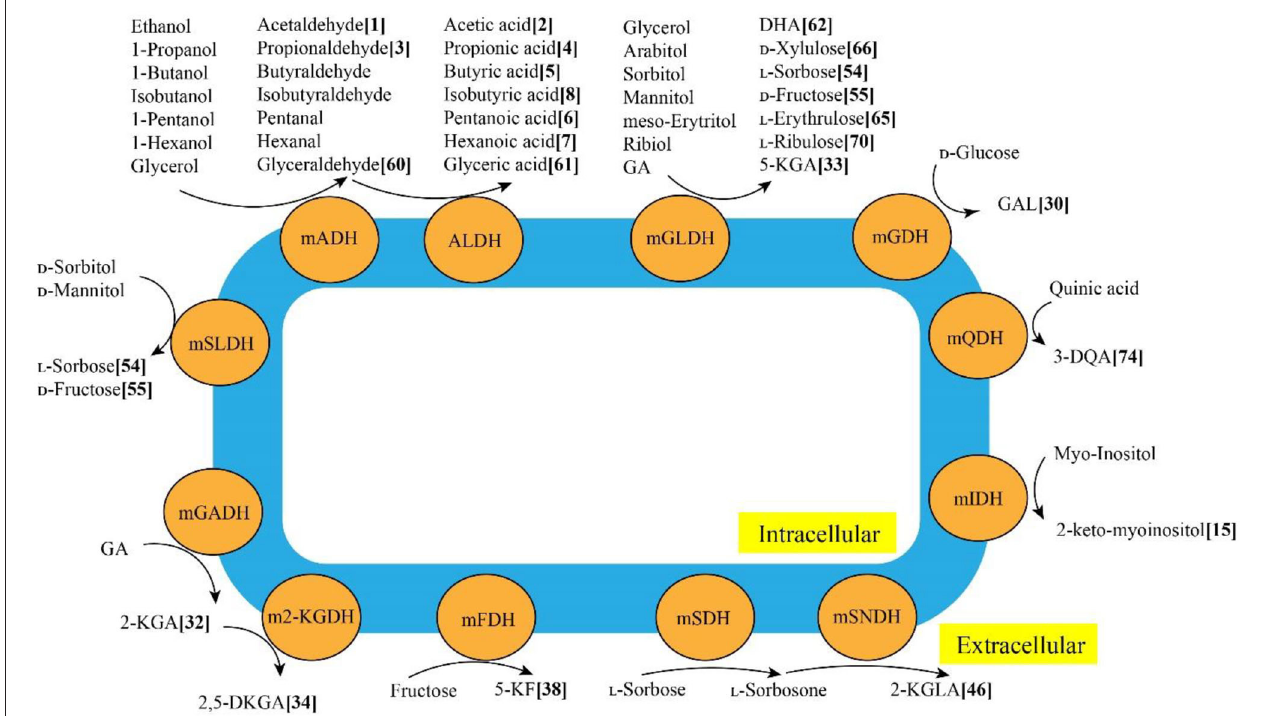
FIGURE 3 | Typical membrane-binding dehydrogenases in acetic acid bacteria and their main AOF products. mADH: membrane-binding alcohol dehydrogenase; mALDH: membrane-binding acetaldehyde dehydrogenase; mGADH: membrane-binding gluconate dehydrogenase; m2-KGDH: membrane-binding 2-keto-D-gluconate dehydrogenase; mFDH: membrane-binding D-fructose dehydrogenase; mSLDH: membrane-binding D-sorbitol dehydrogenase; mGDH: membrane-binding glucose dehydrogenase; mGLDH: membrane-binding glycerol dehydrogenase; mQDH: membrane-binding quinic acid dehydrogenasw; mIDH: membranebinding inositol dehydrogenase; mSDH: membrane-binding sorbose dehydrogenase; mSNDH: membrane-binding sorbone dehydrogenase; GA: gluconic acid; 2-KGA: 2-keto-Dgluconic acid; 2, 5-DKGA: 2, 5-diketo-D-gluconic acid; 5-KF: 5-keto-D-fructose; DHA: dihydroxyacetone; 3-QDA: 3-dehydroquinic acid; 2-KGLA: 2-keto-l-gulonic